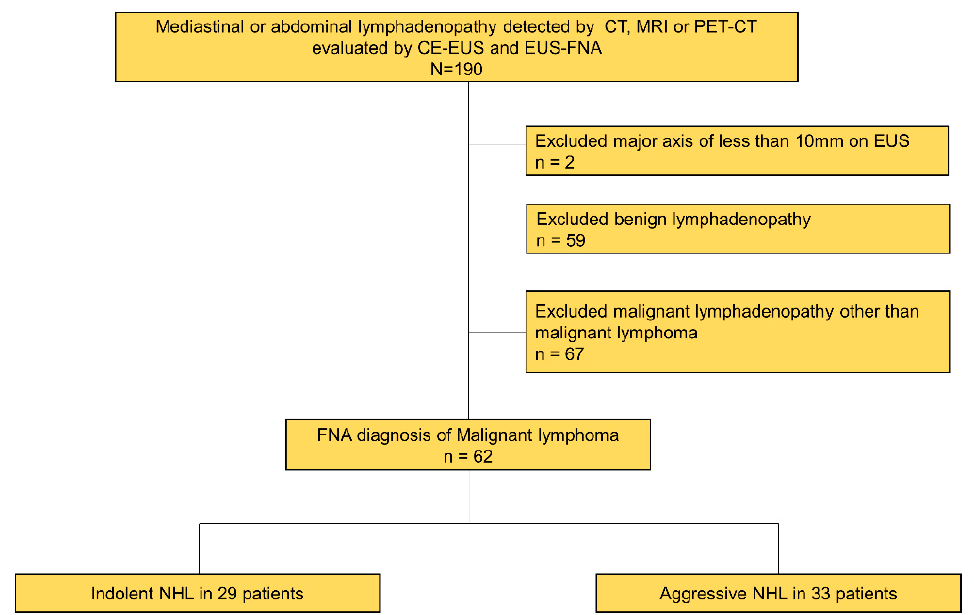
Figure 2. Flow chart of study enrollment. EUS: endoscopic ultrasound, CE-EUS: contrast enhanced- EUS, EUS-FNA: EUS-guided fine-needle aspiration, CT: computed tomography, MRI: magnetic resonance imaging, PET-CT: positron emission tomography-CT, NHL: non-Hodgkin’s lymphomas. Table 1. Baseline characteristics of the patients.